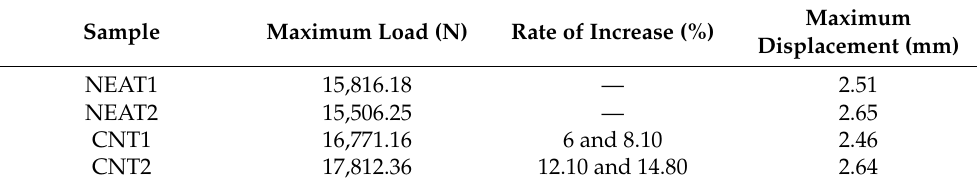
Table 5. The maximum compression load and displacements of